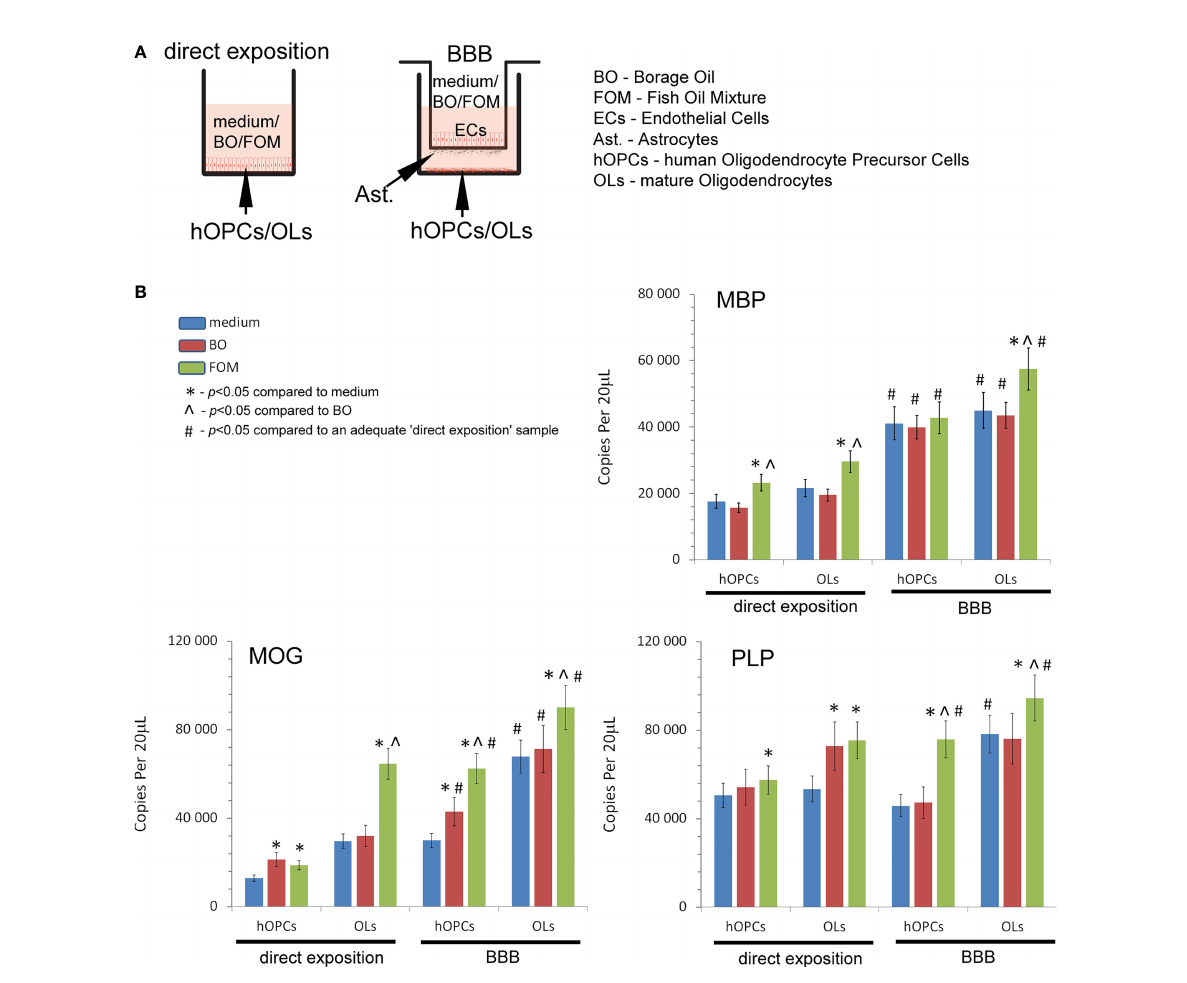
FIGURE 1 Quantitative analysis of the mRNA expression of myelin peptides revealed that hOPCs supplemented with fi sh oil mixture (FOM) contrary to borage oil (BO) during maturation results in enhanced transcription of MOG, PLP, and MBP in mature OLs. This synthesis was further improved by the use of the blood – brain barrier (BBB). (A) Diagram of the experiment performed to characterize the role of the BBB exposed to FOM or BO and their effect on OPC differentiation into mature MBP/PLP/MOG-producing OLs. (B) The quantitative mRNA analysis of MBP, MOG, and PLP expressed by hOPCs and OLs. The results were expressed as the number of gene copies per 20 m l of samples. The graph presented the means ± SD from three independent experiments. The differences between medium/BO/FOM were calculated using the one-way ANOVA test and Scheffe ’ s test. The differences in the adequate groups between “ direct exposition ” and “ BBB model ” were calculated using the paired